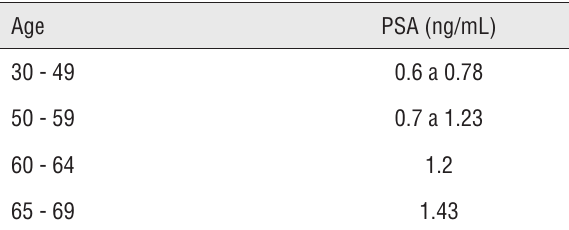
Table 1 - psA mean level in healthy men